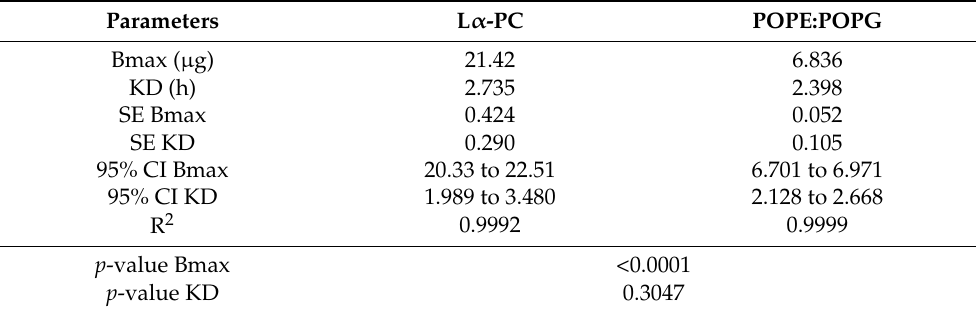
p -value Bmax p -value KD